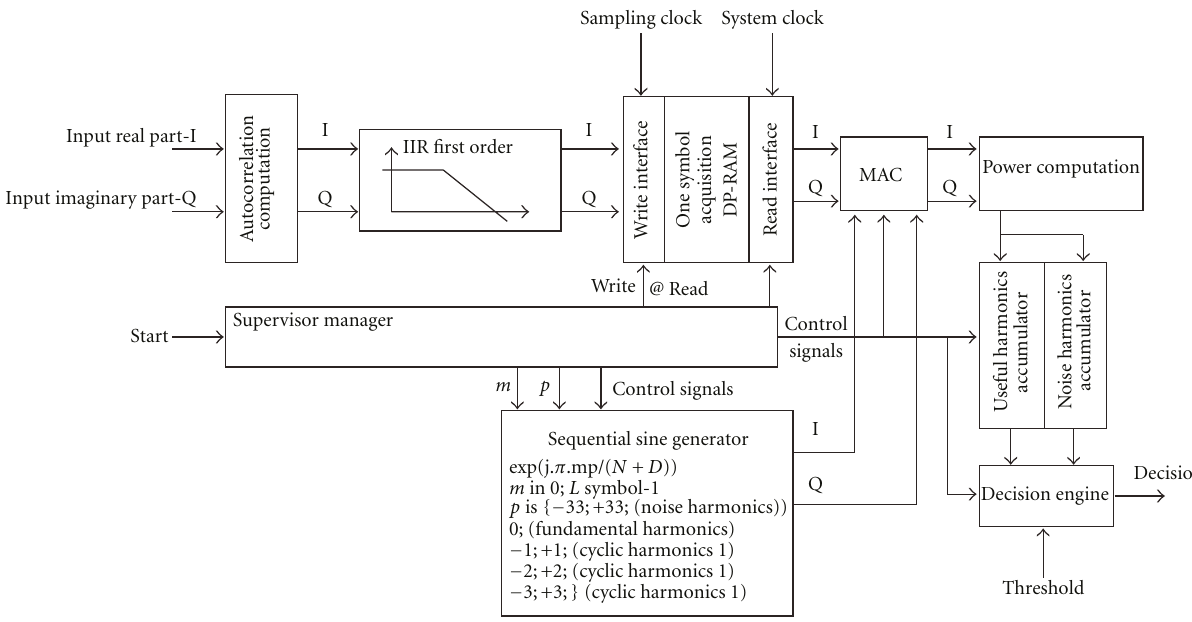
Figure 9: Cyclostationarity detector for DVB-T